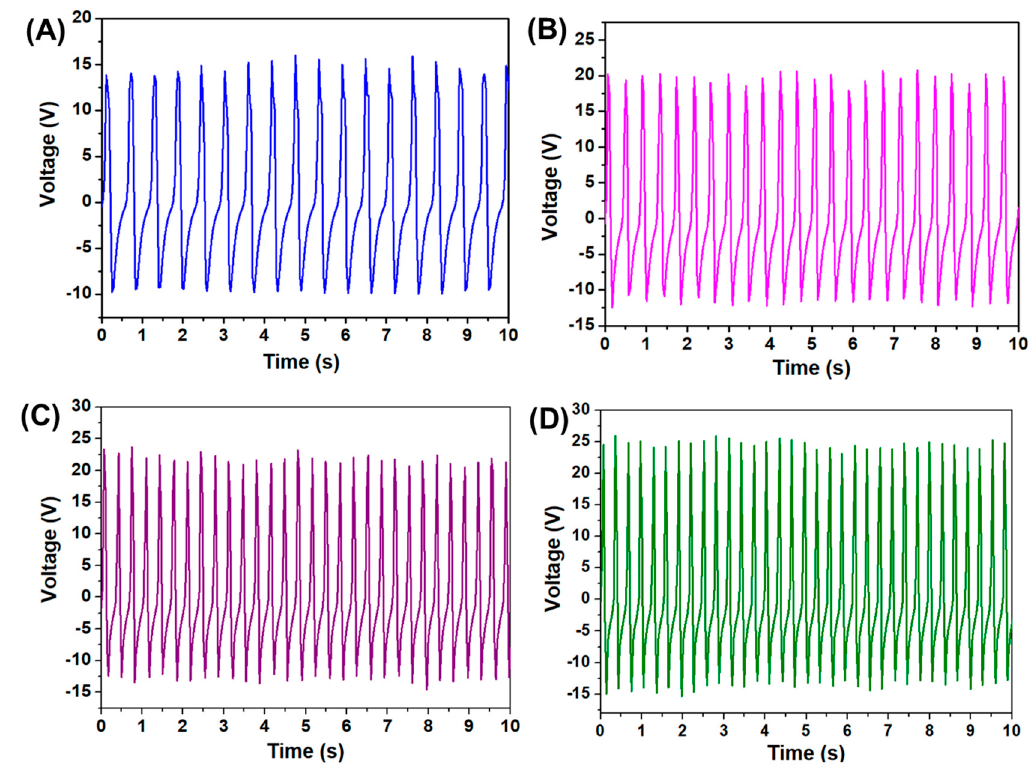
Figure 2. ( A – D ) the voltage output of PVDF/sodium niobate nanogenerator device measured under various compressive forces (10 to 40 N).